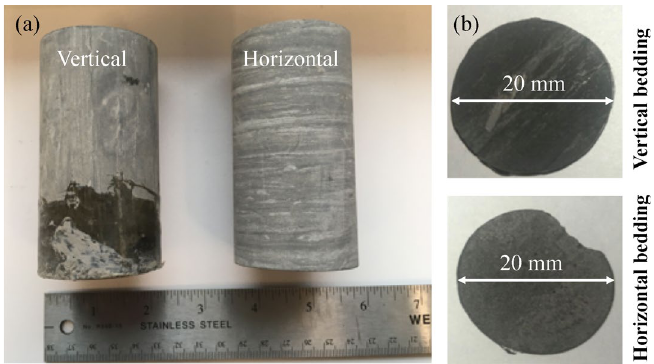
Figure 9. Polished samples cut from cores obtained along vertical and horizontal bedding